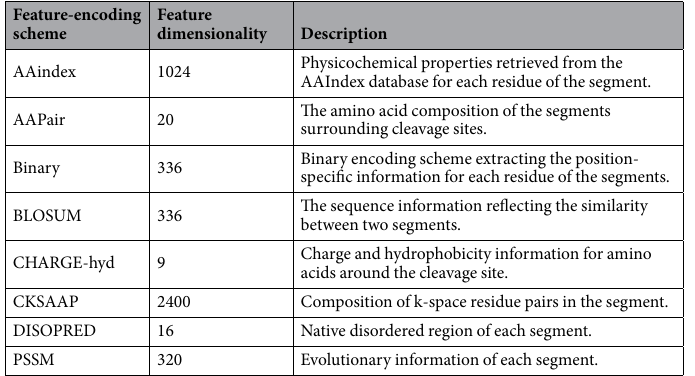
Table 1. A list of features extracted for each feature-encoding scheme.